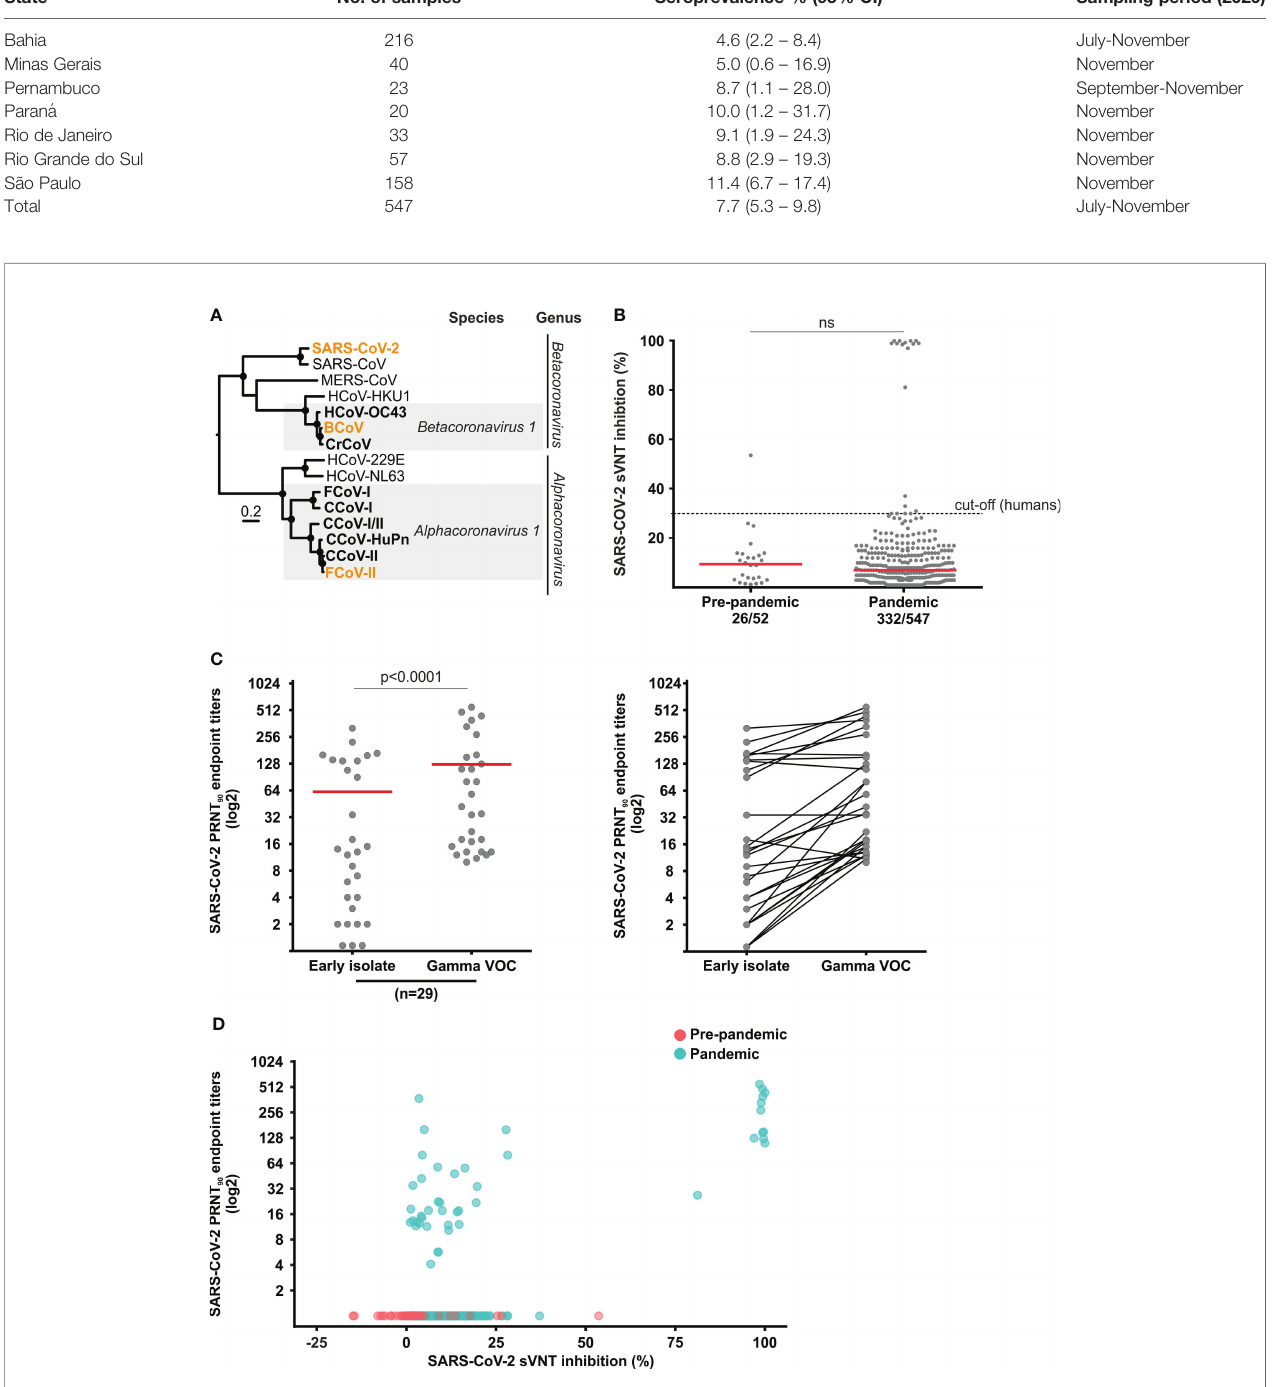
TABLE 1 | SARS-CoV-2 seroprevalence in cats from different states in Brazil. State No. of